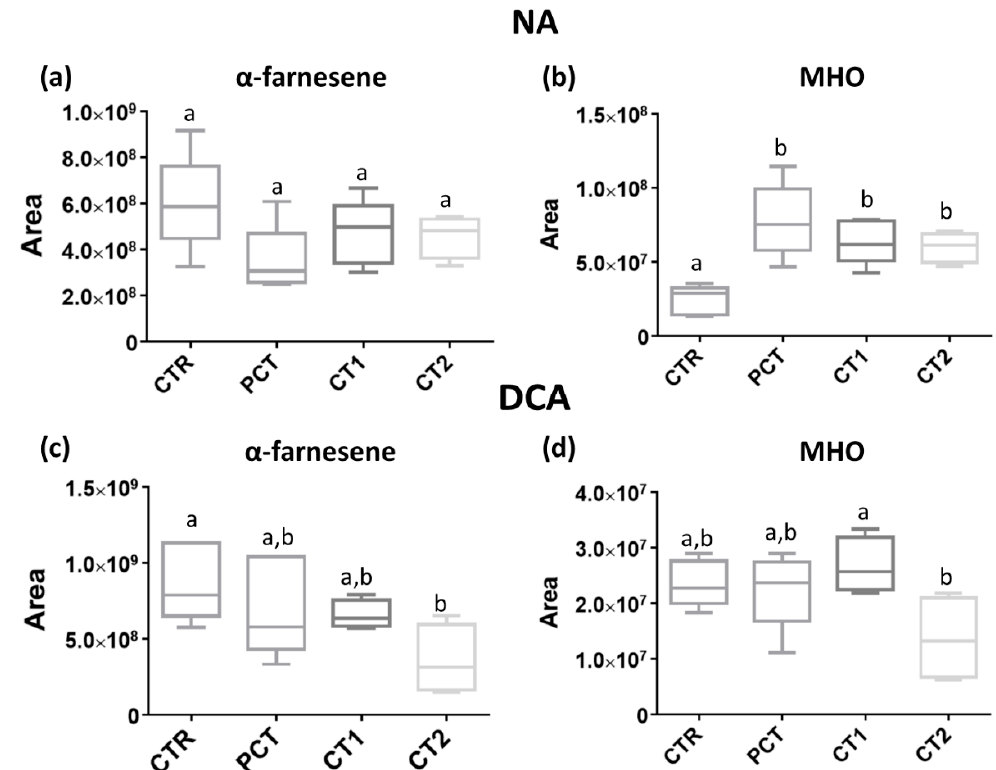
Figure 9. Boxplot representation of absolute areas of α -farnesene and 6-methyl-5-hepten-2-one (MHO) at day 134. ( a , b ) NA (normal atmosphere); ( c , d ) DCA (dynamic controlled atmosphere) storage conditions. For each storage, four coating conditions are presented as follows: CTR (control), PCT (pectin), CT1 (coating 1), and CT2 (coating 2). Each boxplot represents the areas of five replicates. The same lowercase letter indicates no significant differences between conditions ( p < 0.05).